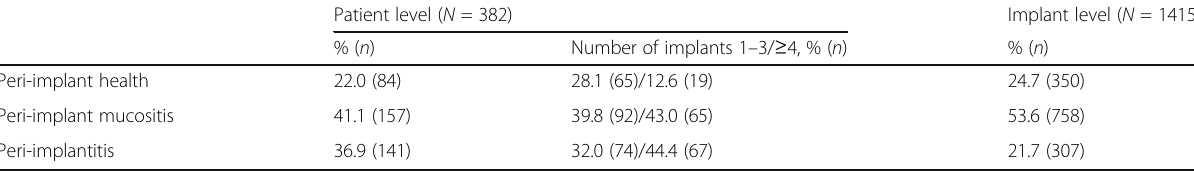
Table 3 Prevalence of peri-implant health and disease at patient and implant levels